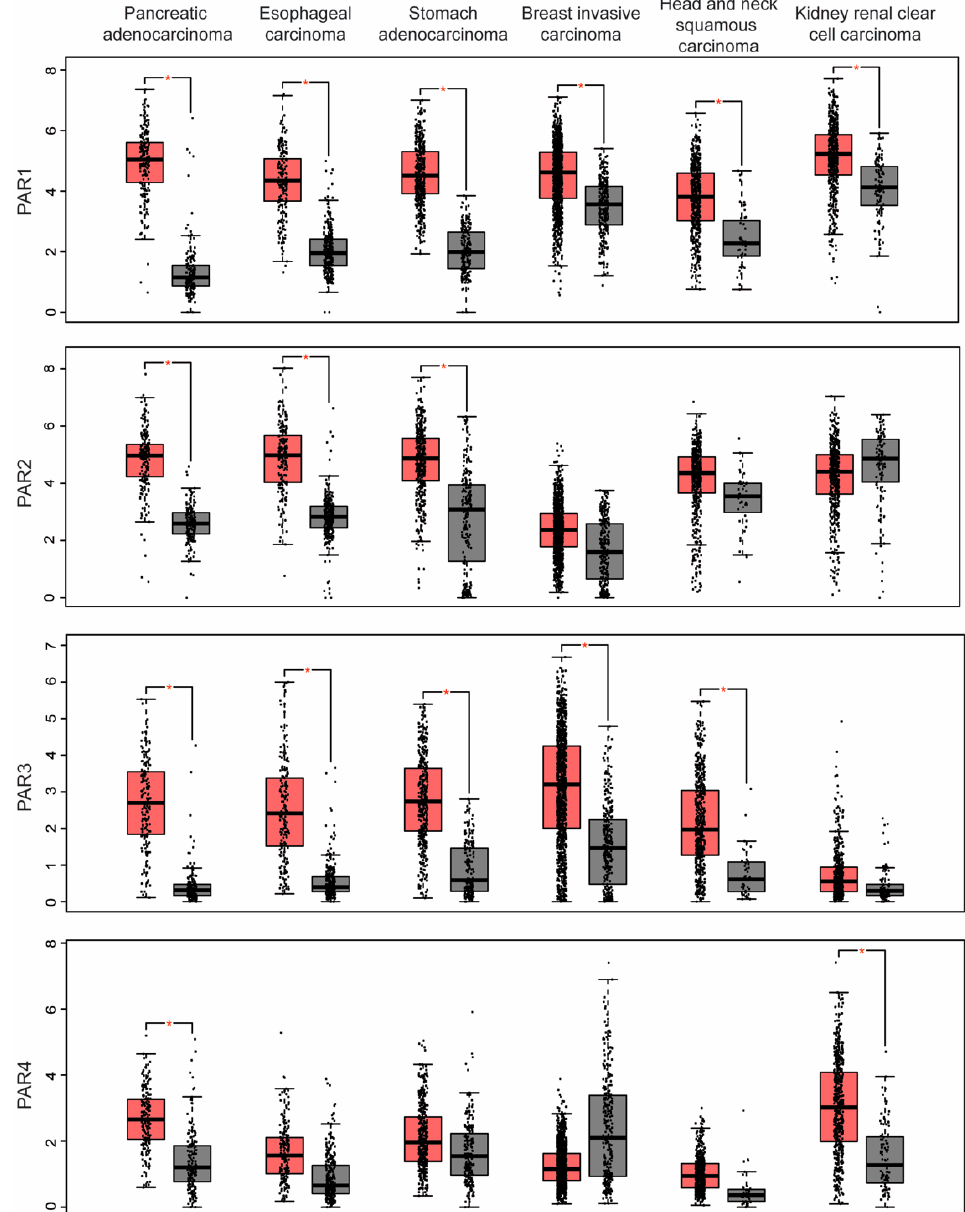
Figure 1. Co-expression of protease-activated receptors in human cancers. GEPIA analysis revealed that multiple PARs are significantly overexpressed in various cancer types. Pancreatic adenocarcinoma (179 tumor, 171 normal) overexpresses all PARs compared to normal tissue; esophageal carcinoma (182 tumor, 286 normal) and stomach adenocarcinoma (408 tumor, 211 normal) overexpress PAR1, PAR2, and PAR3, whereas breast invasive carcinoma (1085 tumor, 291 normal) and head and neck squamous carcinoma (519 tumor, 44 normal) overexpress PAR1 and PAR3 and kidney renal clear cell carcinoma (523 tumor, 100 normal) overexpress PAR1 and PAR4. The RNA-seq data are expressed as relative gene expression using transformed log 2 (TPM+1) value ( Y -axis) of tumor (red) and normal (grey) samples from different cancer types and displayed as a whisker plot. The whisker plot solid horizontal black line is the median, the box represents the upper and lower quartiles and the two lines (whiskers) outside the box extend to the highest and lowest observations of the sample population. The difference in PAR expression in tumors compared to normal tissue control is significant based on one-way ANOVA (* p < 0.01). TPM, transcript per million.